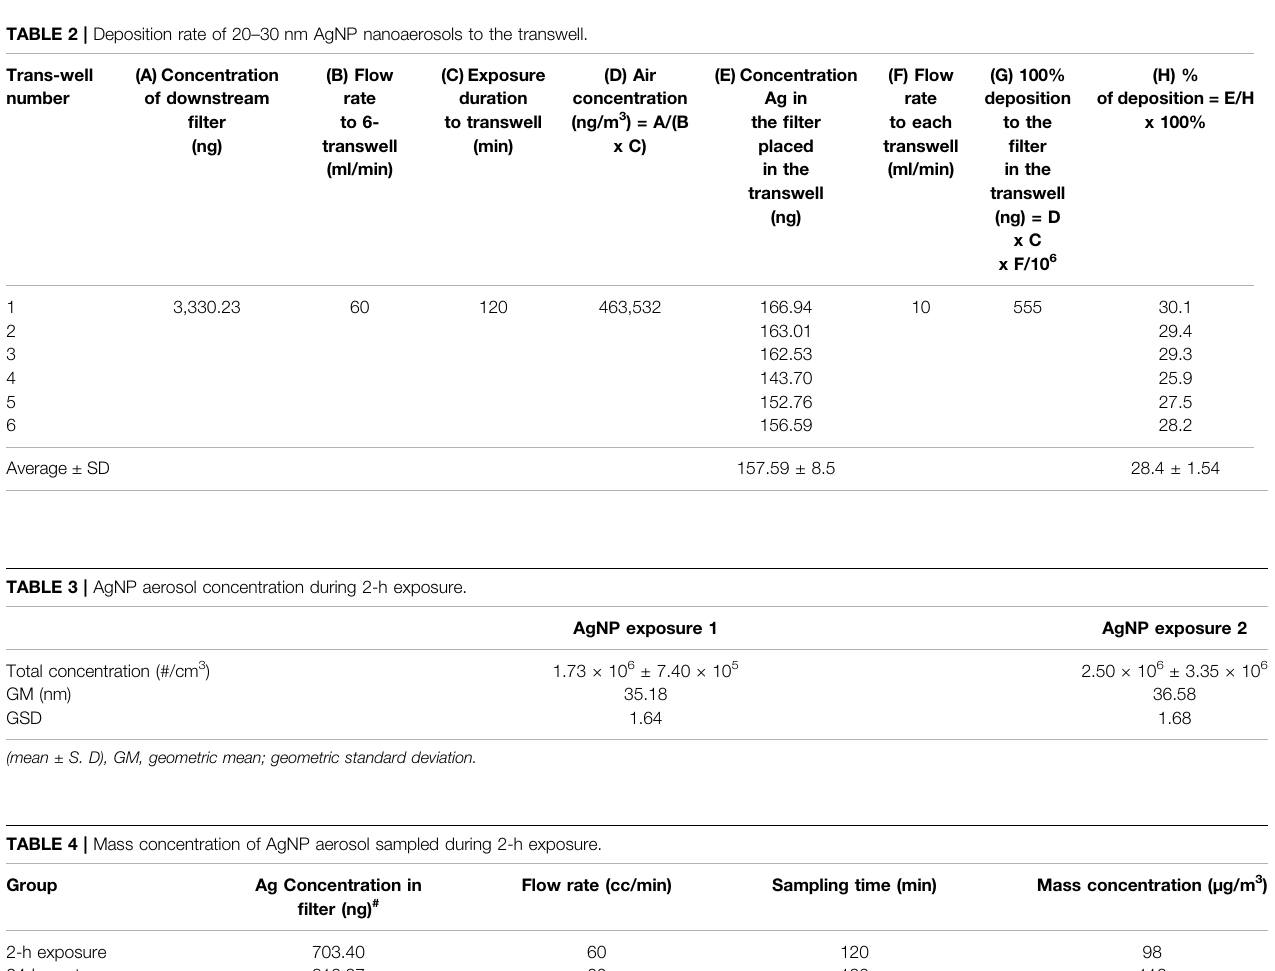
#Measured by atomic absorption